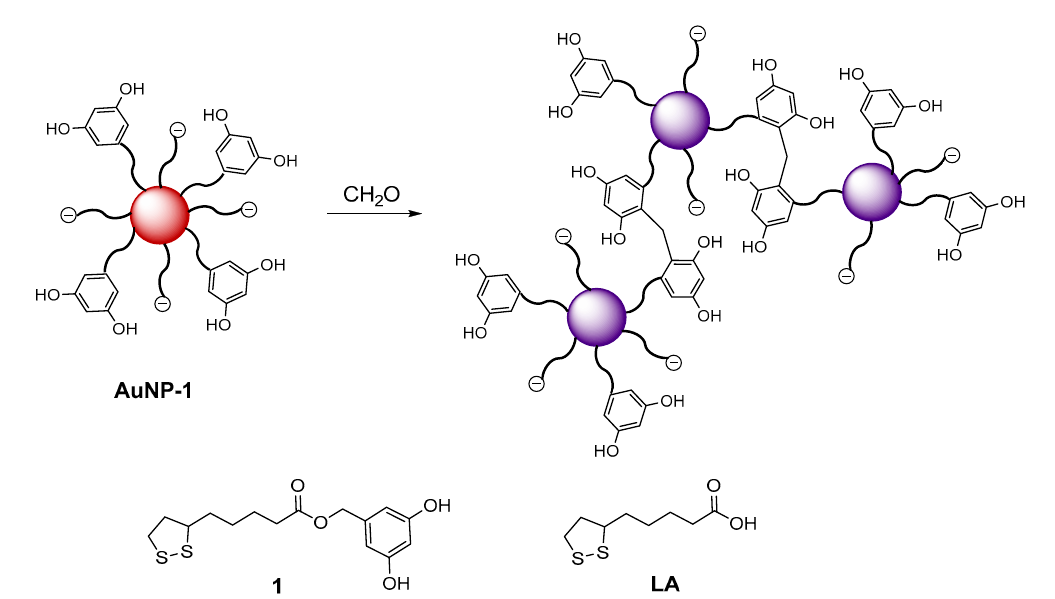
Figure 1. Proposed sensing mechanism and structure of the ligands used in AuNP-1 preparation.